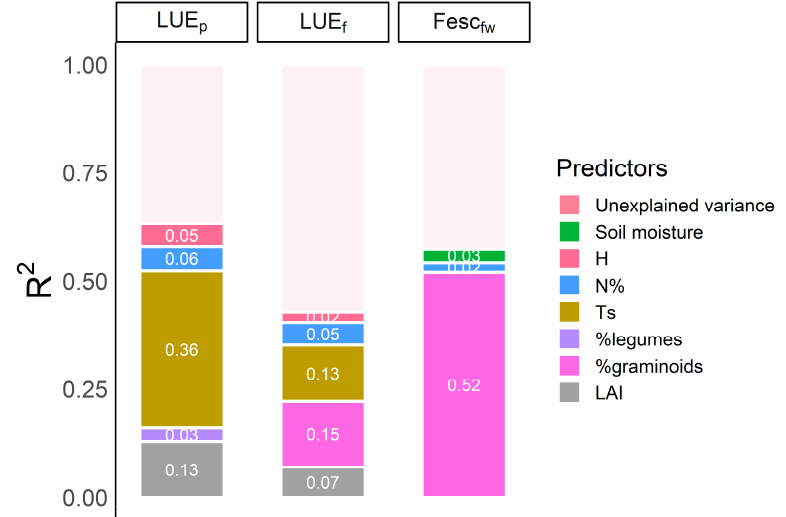
Figure 5. Relative importance analysis with “lmg”(Lindeman, Merenda and Gold) method of Light use efficiency of photosynthesis (LUE p ), Light use efficiency of fluorescence emission at 760 nm (LUE f ) and escape probability of sun-induced fluorescence at 760 nm obtained from forward runs of SCOPE (Fesc fw ). Predictors included in the analysis are: soil moisture, Shannon biodiversity index (H), canopy nitrogen content (N%), surface temperature (Ts), relative abundance of legumes (%legumes), relative abundance of graminoids (%graminoids) and leaf area index (LAI). Error bars (1 SE) are calculated through bootstrapping (n = 1000), but are not shown in the figure. They are however reported in the result section. Results of the relative importance analysis for GPP, F 760 , and F 760leaf.fw show the importance of LAI that controls the seasonality of canopy structure and APAR (Figure S15).